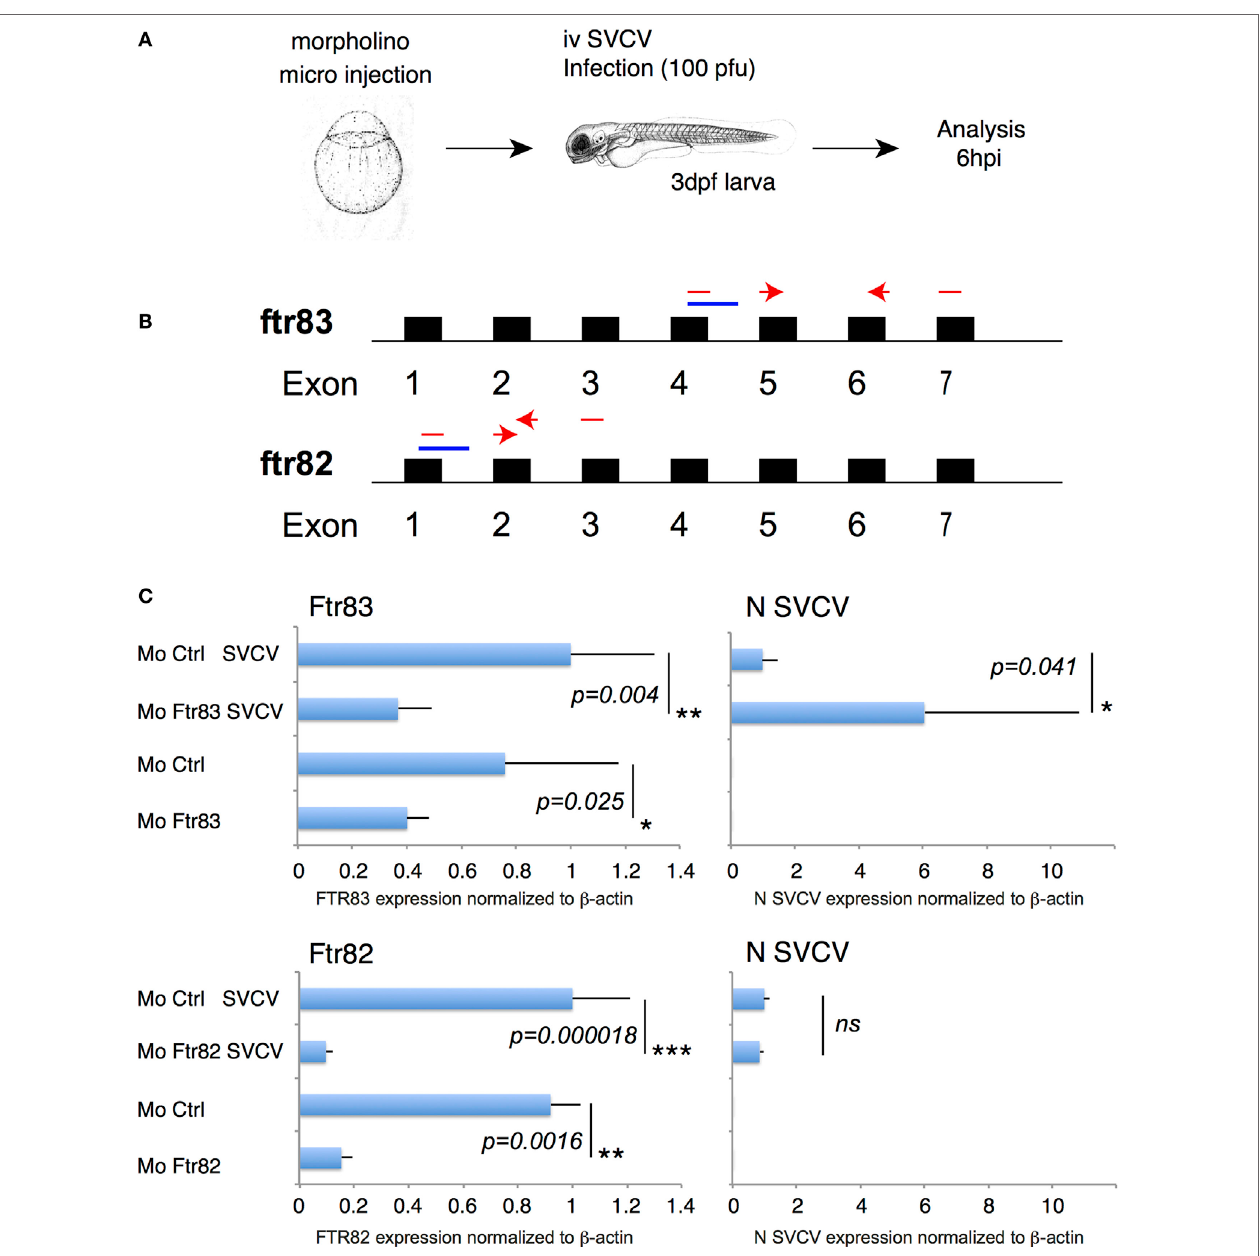
FigUre 7 | Ftr83 exerts antiviral activity in vivo in zebrafish embryo . (a) Schematic drawing of the loss of function experiment in zebrafish embryos. Embryos were injected at the one-cell stage with 4 ng of the ftr83, ftr82 or control morpholino, injected at 72 hpi with 100 pfu of spring viremia of carp virus (SVCV), and analyzed 6 hpi. (B) Schematic representation of the location of splice ftr83 and ftr82 morpholinos in the respective genes (in blue). Primers allowing to distinguish between spliced and unspliced mRNA are shown in red. (c) The expression of ftr83 , ftr82 , and viral N transcripts was quantified 6 hpi by RT-PCR. Results were normalized on the β -actin expression. The larvae were injected with the ftr83 morpholino (MO Ftr83), with the ftr82 morpholino (MO ftr82), or with the control morpholino (MO Ctlr), and infected with SVCV infection or mock-infected. Data are shown relative to the expression level of the analyzed mRNA in larvae injected with the ftr83 morpholino (upper panels) or with the ftr82 morpholino (lower panels) and infected by SVCV (set to 1). Mean and SD are shown, for four independent experiments. Stars indicate significant differences using Student’s t -test (* p <